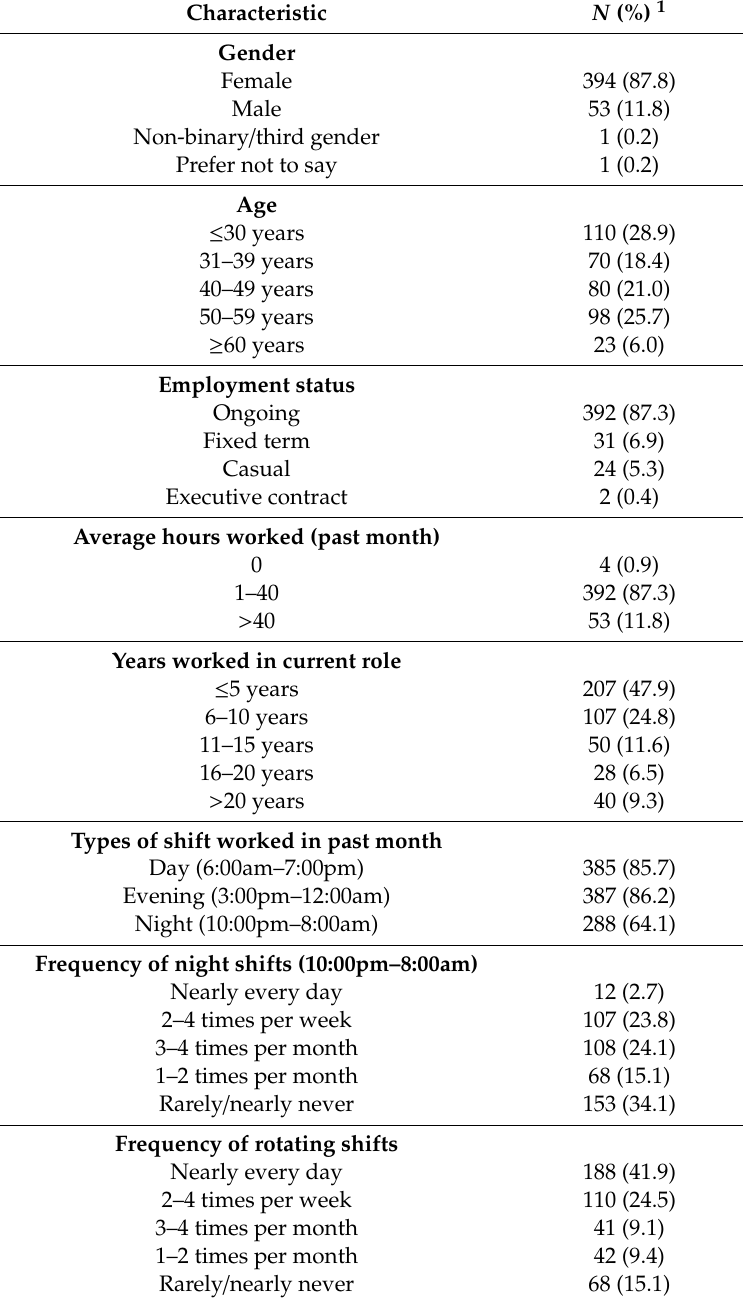
Table 1. Sociodemographic and occupational characteristics of shift working